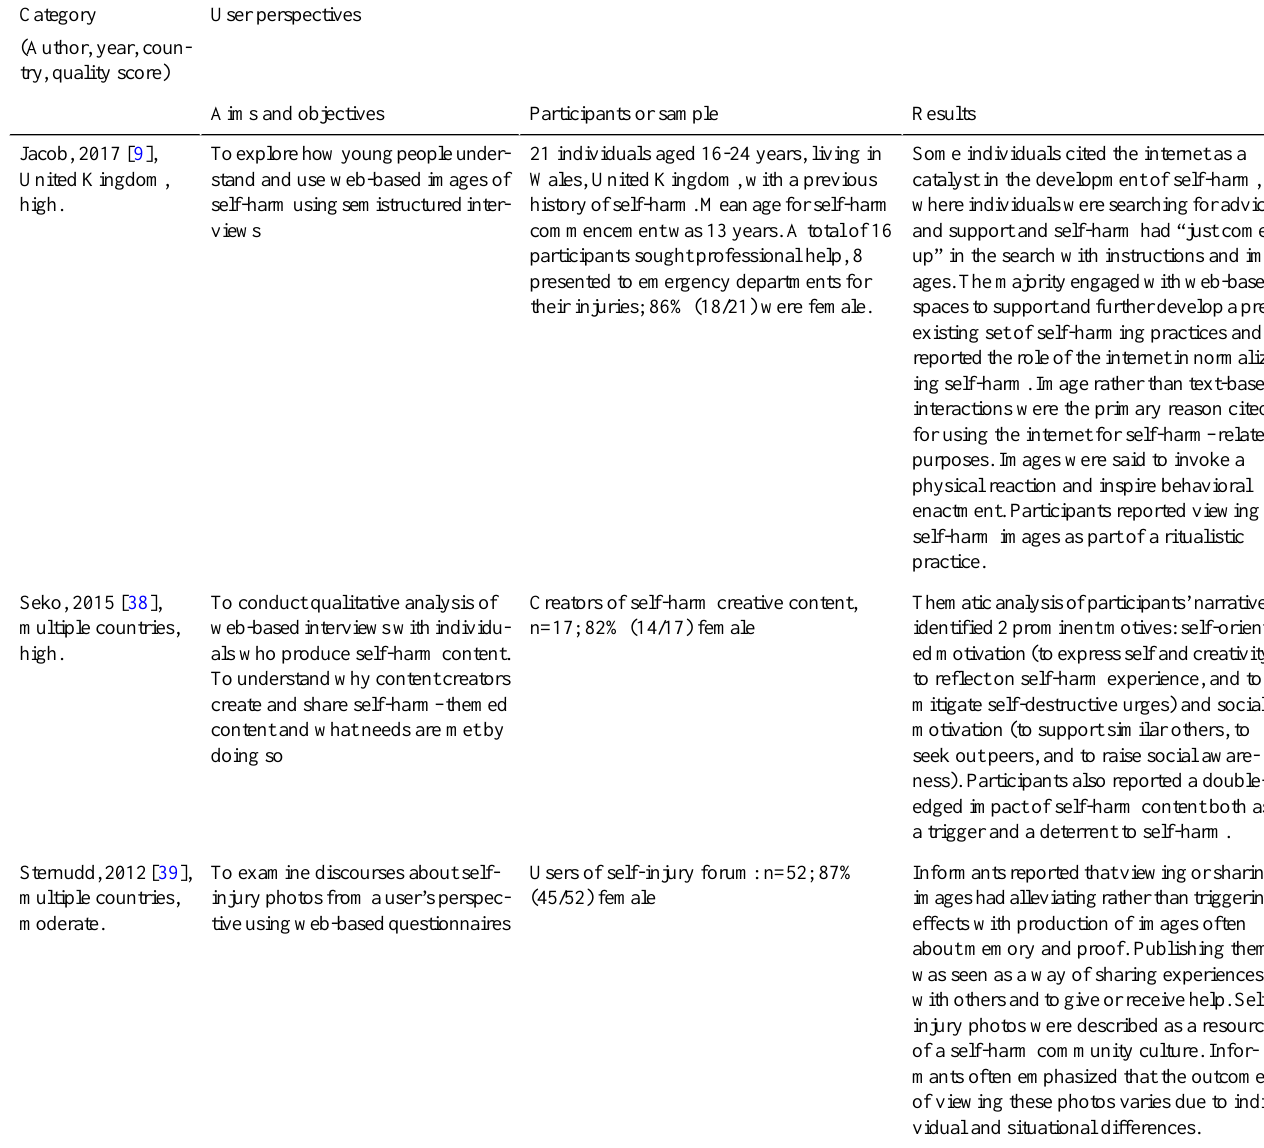
Table 2. Summary of included studies examining the perspectives of individuals on the impact of sharing and viewing web-based images or videos of